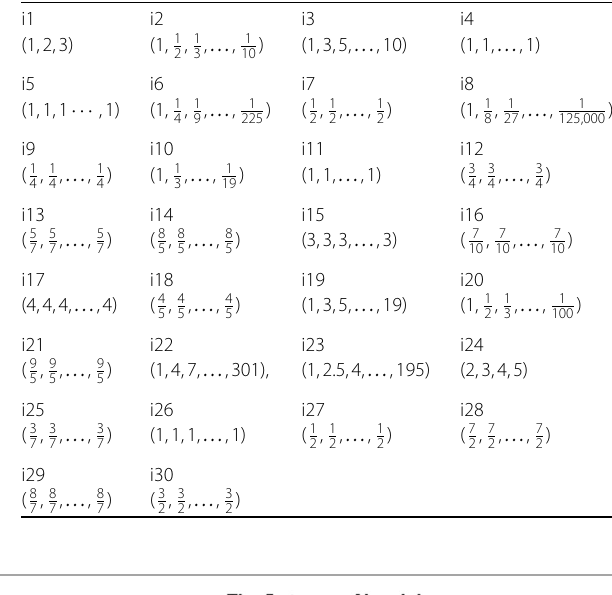
Table 2 Initial points used in Table